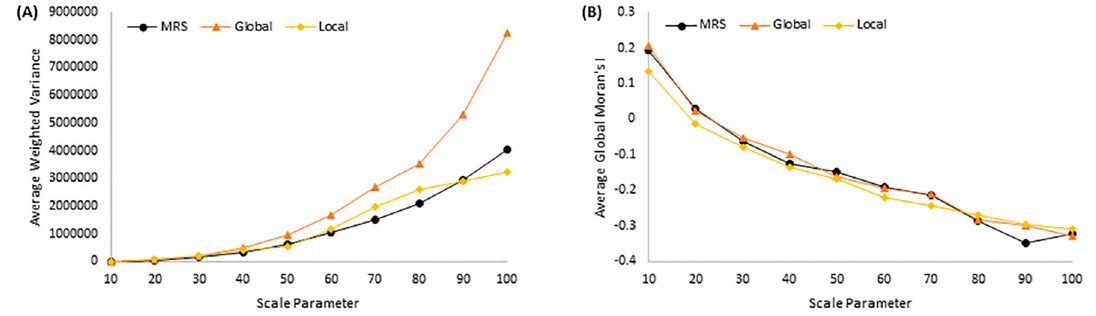
Figure 2. The performance of the three segmentation methods according to the three-band average ( A ) weighted variance ( wVar ) and ( B ) Moran’s I values.